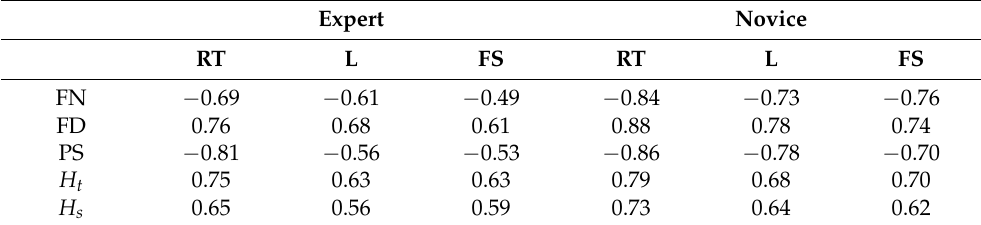
Table 6. Correlations among PVT measures and eye movement